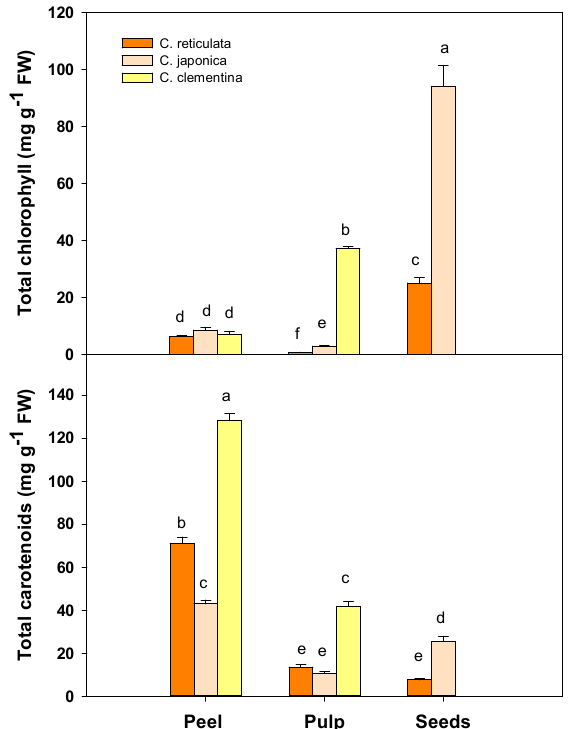
Figure 3. Total chlorophyll (a + b) and total carotenoid (x + c) content of peel, pulp and seeds in the three different mandarin cultivars: C. reticulata (Phlegrean mandarin), C. japonica (Kumquat) and C. clementina (Clementine). Each bar represents the mean ± SE ( n = 6). Different letters indicate statistically significant differences among mandarin varieties ( p < 0.05). Results were analysed by one- way ANOVA followed by Holm–Sidak post hoc test for multiple comparisons.